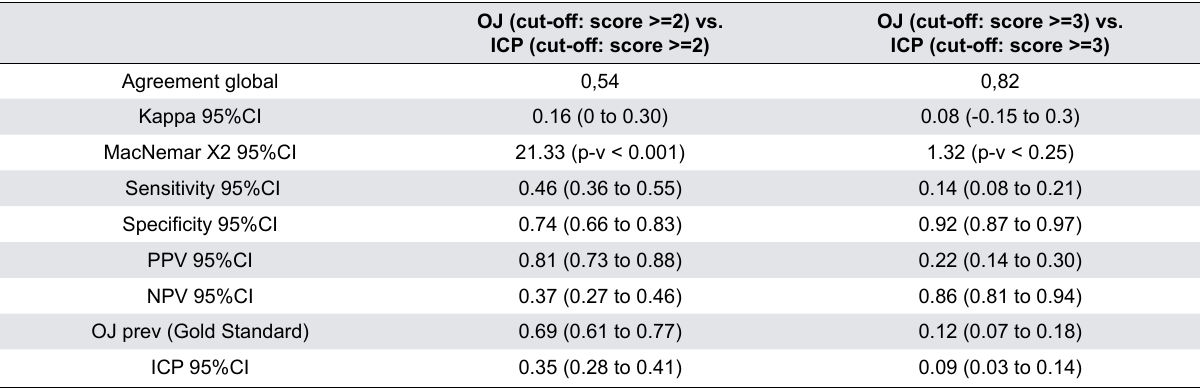
Table 6- Accuracy of the interview with a close person (ICP) compared to organoleptic assessment by a trained professional